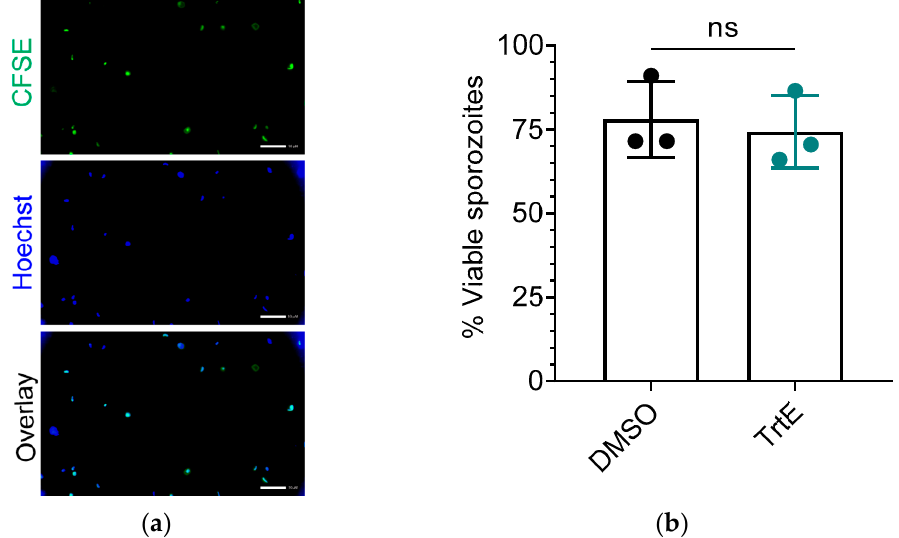
Figure 4. TrtE does not affect sporozoite viability. Sporozoites were labeled with 10 µM CFSE after compound treatment to determine their metabolic viability. DNA was labeled with 0.9 mM Hoechst dye. ( a ) Representative images of DMSO treated C. parvum sporozoites in suspension. Scale bar represents 10 µm. ( b ) Quantification of viable sporozoites. The graph shows the percent of viable sporozoites (mean ± SD of three independent experiments). Experimental groups were compared with an unpaired t-test; ns = not significant.